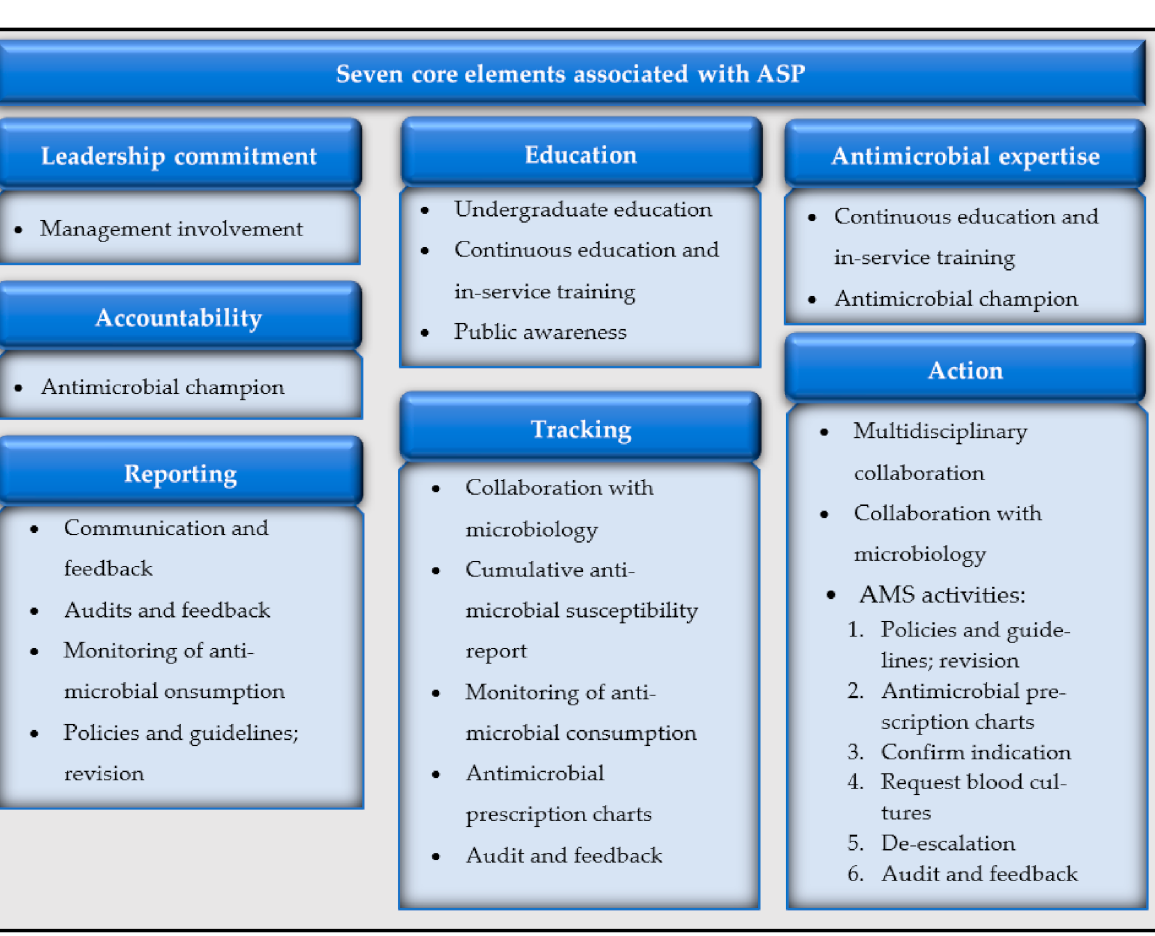
Figure 1. Emerging aspects pertaining to the core elements of